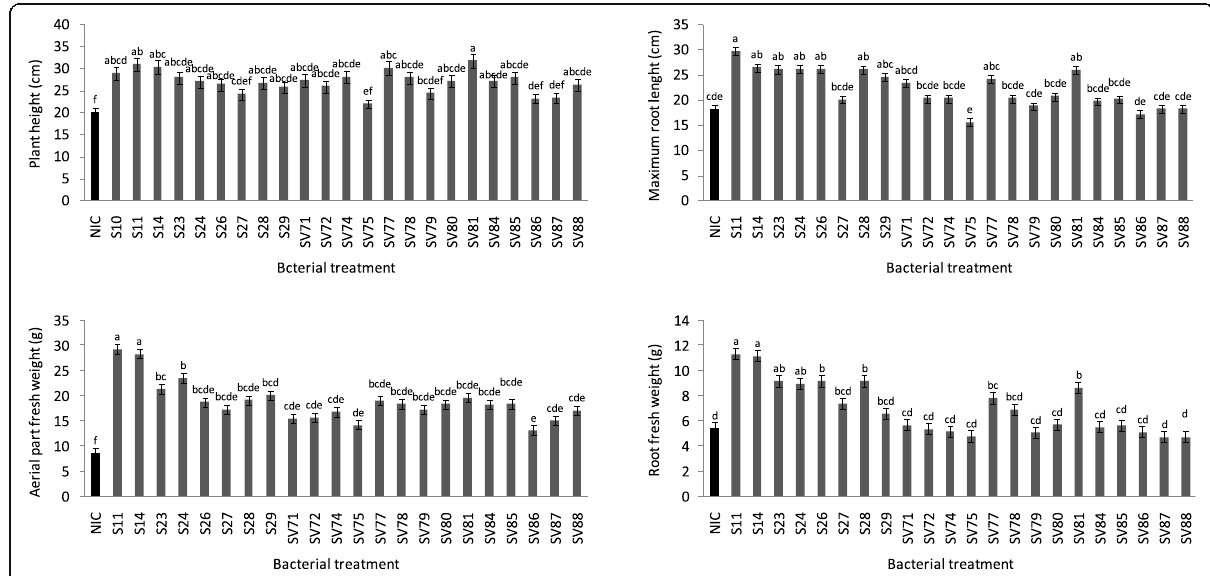
Fig. 1 Plant growth-promoting potential of various endophytic bacterial isolates, recovered from Solanum sodomaeum and S . bonariense , noted on pathogen-free tomato cv. Rio Grande plants 60 days post-treatment. S11, S14, S26, S27, S28, and S29 are isolates issued from S . sodomaeum . S23, S24, SV71, SV72, SV74, SV75, SV77, SV78, SV79, SV80, SV81, SV84, SV85, SV86, SV87 and SV88 are bacterial isolates recovered from S . bonariense . NIC, untreated control. Bars sharing the same letter are not significantly different according to Student-Newman-Keuls test at P ≤